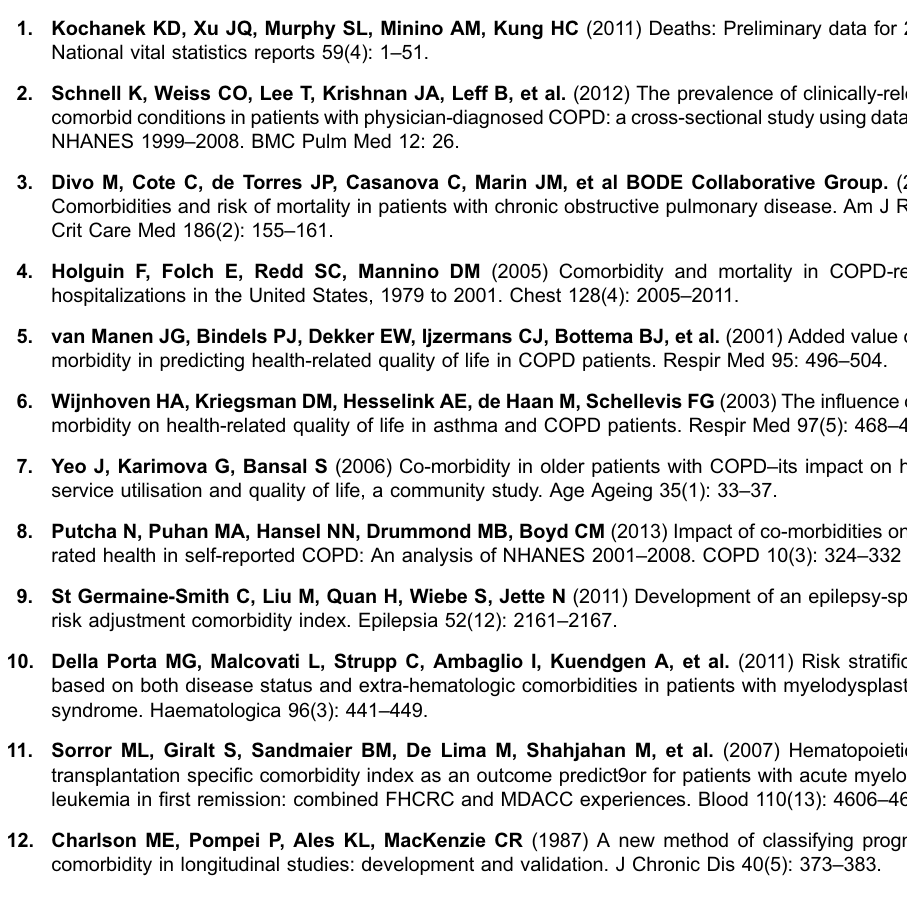
S6 Table. Discrimination measures (AUC) and calibration measures (Hosmer- Lemeshow calibration statistics) for comorbidity count with regards to outcomes of exacerbations, MMRC, and 6MWD, in the former and current smoking control SPIROMICS participants (current and former smokers without